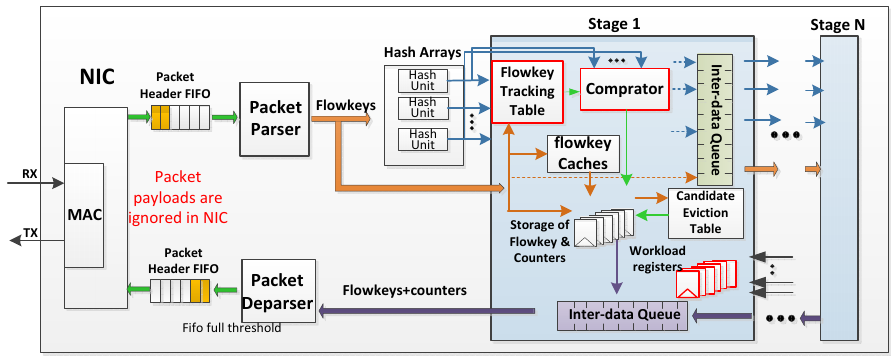
Figure 2. Block diagram of SAPTM